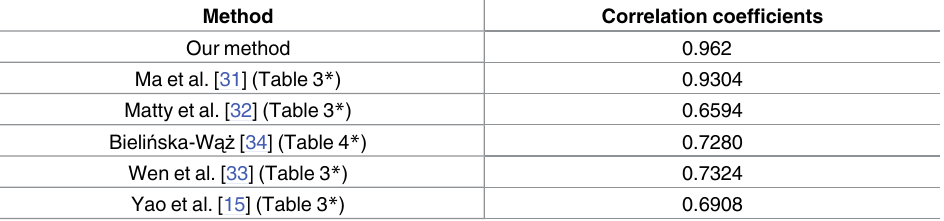
Table 4. Comparison of 6 alignment-free methods.